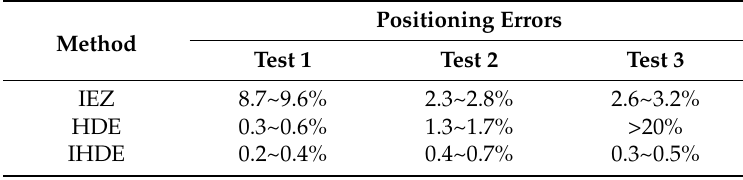
Table 2. The results of positioning errors in each